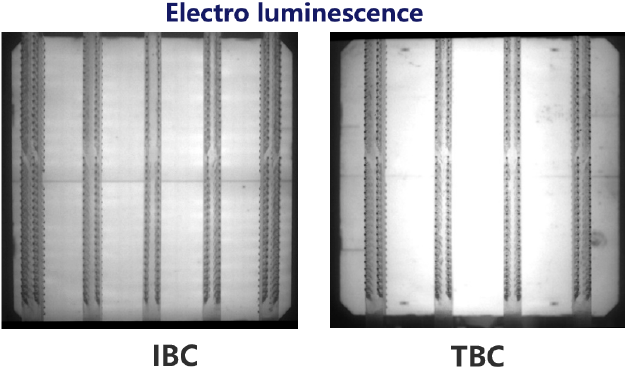
Figure 9. Electroluminescence images of IBC (reference) and TBC solar cells processed in the same experiment.